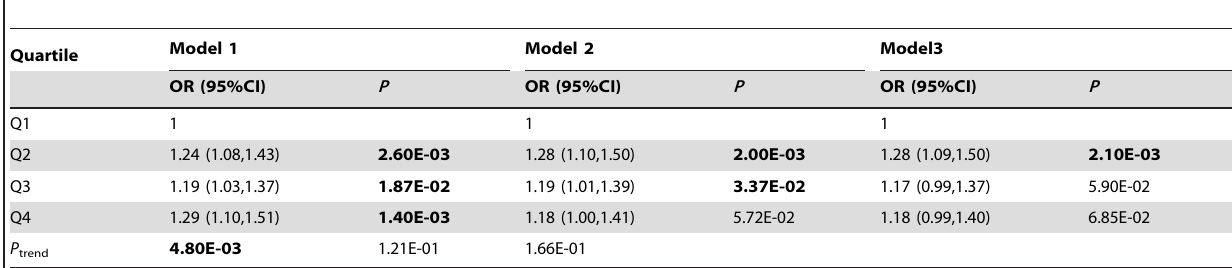
Table 3. Joint effects of obesity-related risk alleles on the risk for type 2 diabetes in study population.